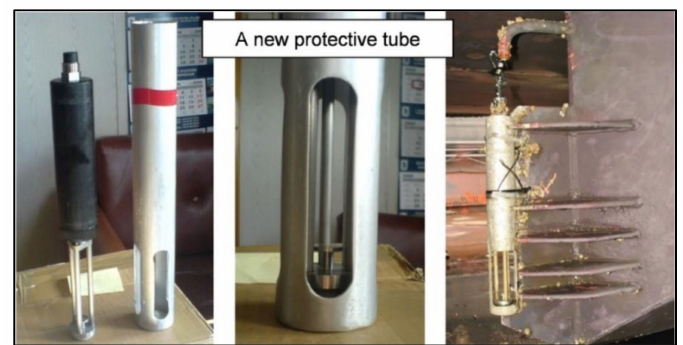
Figure 13. Sound velocity sensor placed in a special protective tube.